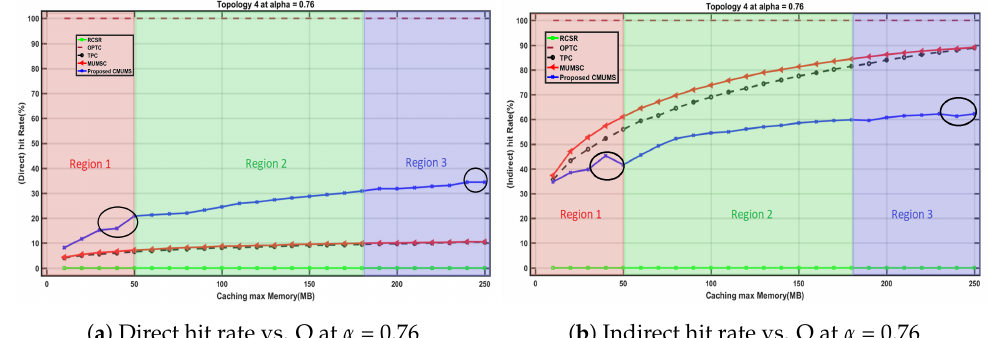
Figure 12. Direct and Indirect hit rate behavior vs.